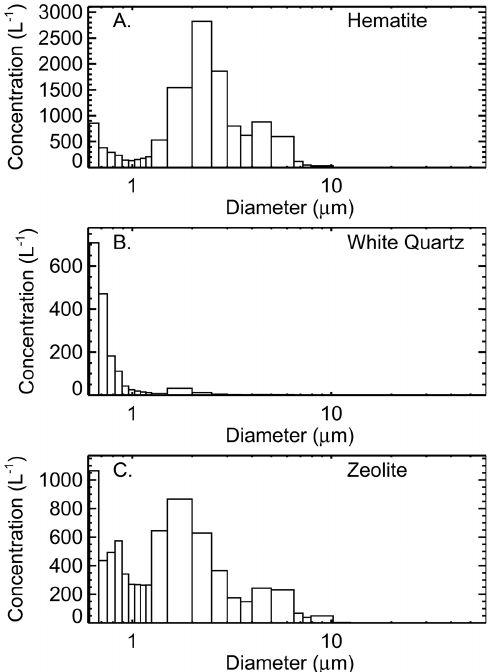
Fig. 7. Average particle size distributions as measured by the CASPOL for three dust types: hematite, white quartz and zeolite.